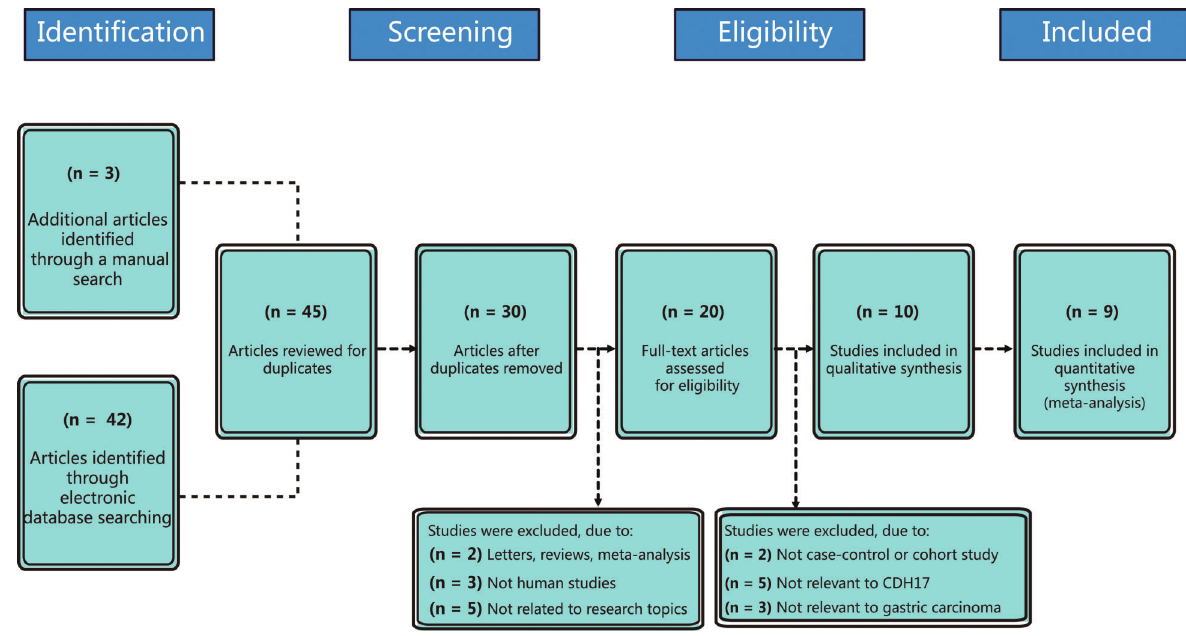
Figure 1. Flow chart showing the detailed study inclusion and exclusion procedures. Nine cohort studies were included in this meta- analysis.